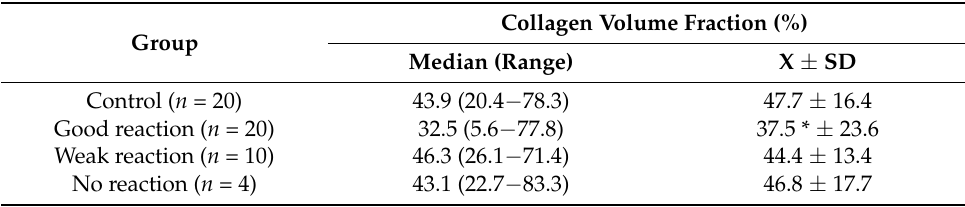
Figure 1. Representative light micrographs of myomas in the control group ( A , E ); in the group with good reaction to UPA (ulipristal acetate) treatment ( B , F ); in the group with weak reaction to UPA treatment ( C , G ) and in the group with no reaction to UPA treatment ( D , H ). A – D : hematoxylin and eosin staining; E – H : Mallory’s trichrome staining. Scale bar—100 µ m. C—control group; GR—good reaction to treatment; WR—weak reaction to treatment; NR—no reaction to treatment. Table 2. The percent of collagen volume fraction in fibroids in the control group and in the groups after three months of treatment with ulipristal